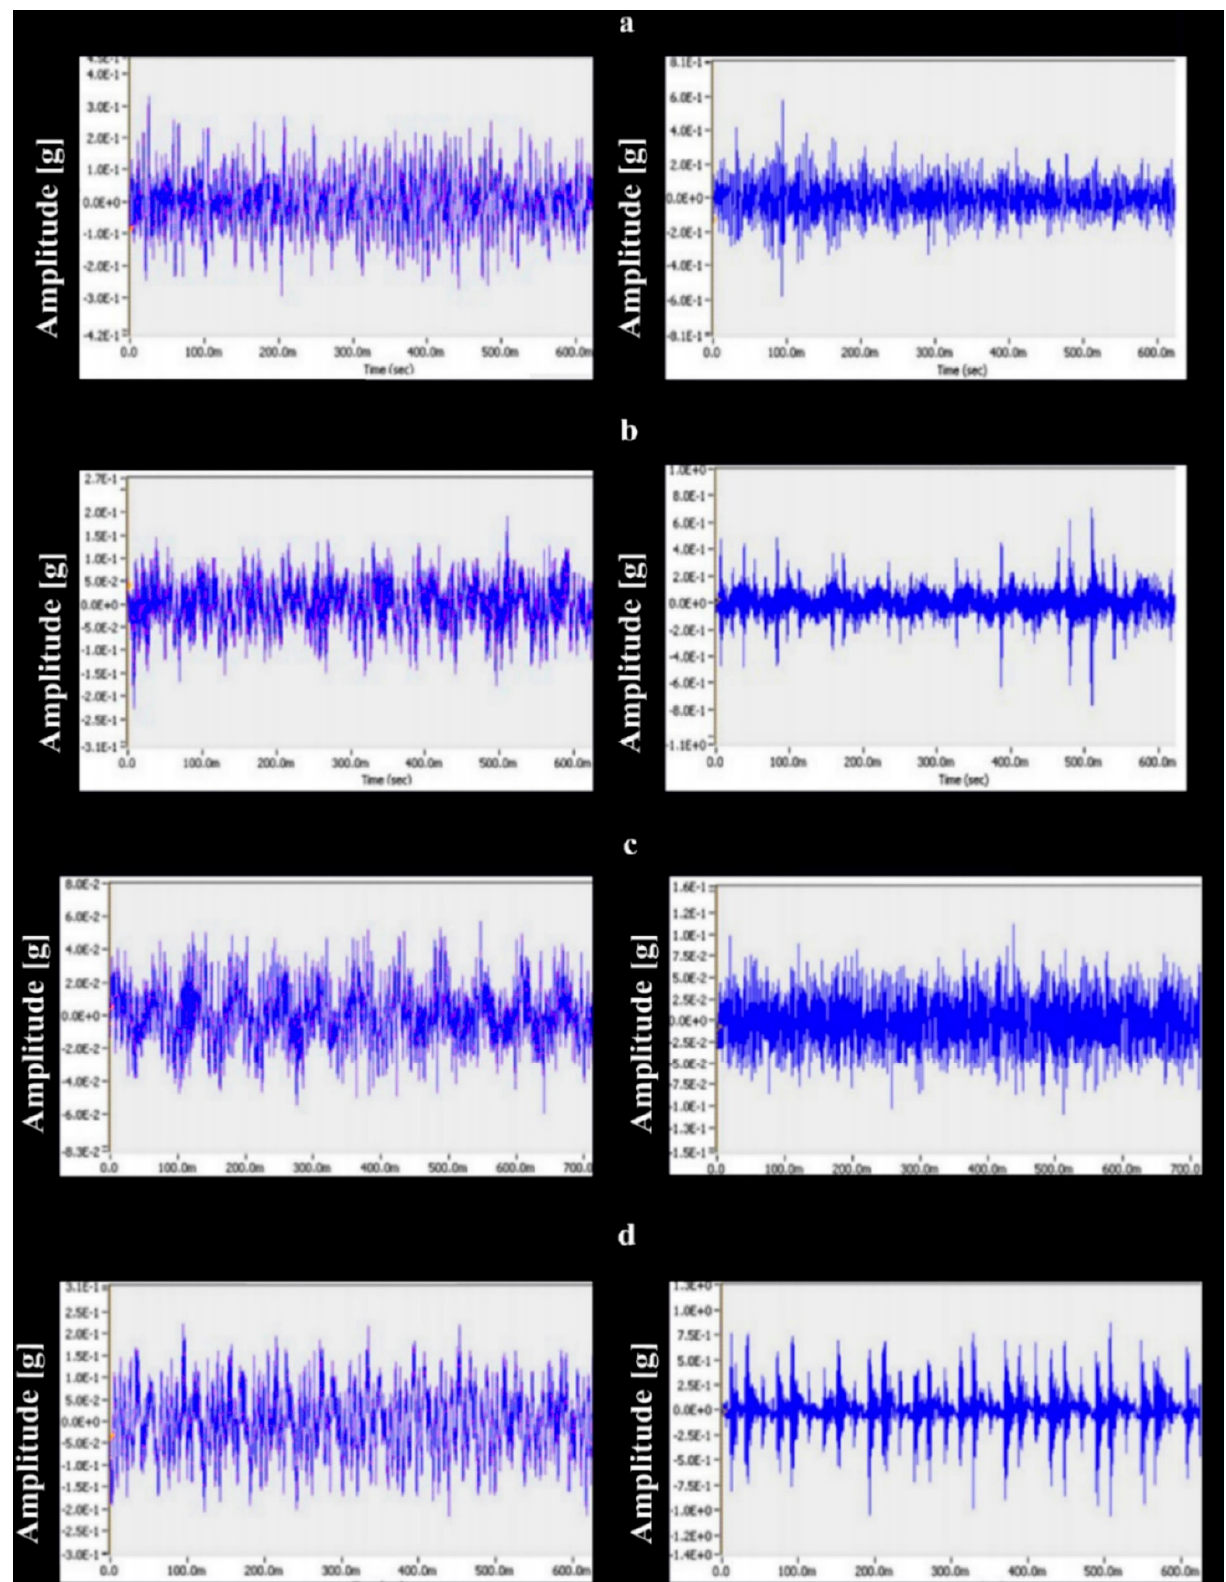
Figure 8. Time Waveform of Case Western Reserve University Bearing Dataset ( a ) vibration signals for healthy bearing ( b ) bearing with outer race crack, ( c ) bearing with rough inner race surface and ( d ) ball with corrosion pitting all at 2000 rpm with no loader. Right side time waveforms are vertical response and left side waveform are horizontal response.